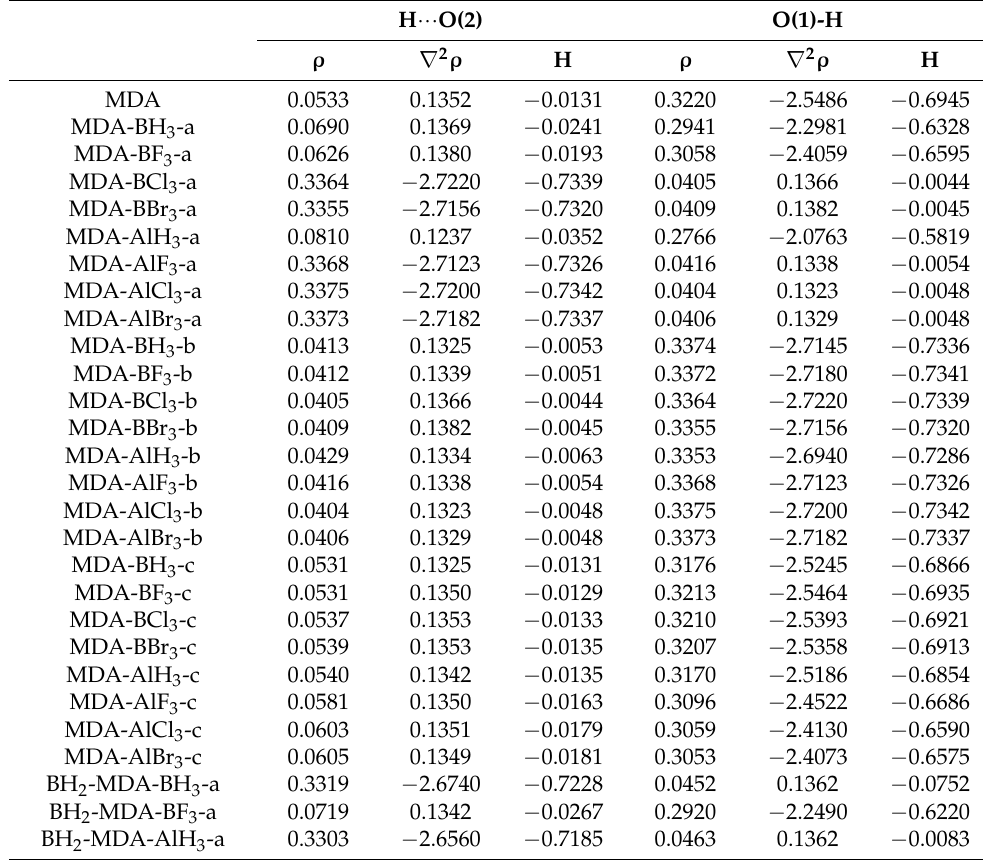
Table 4. Electron density ( ρ ), Laplacians ( ∇ 2 ρ ), and energy density (H) at the H ··· O and O-H BCPs in the complexes, all in